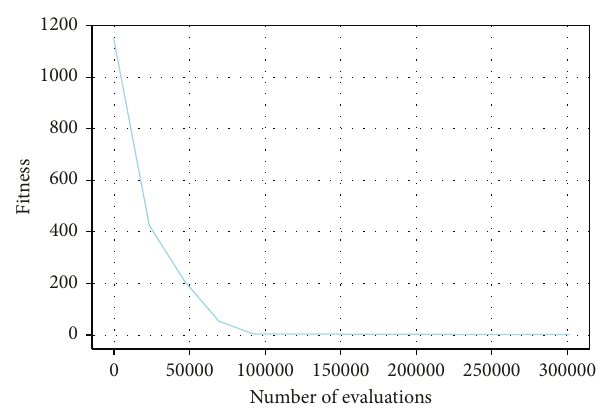
Figure 5: CEC14 Fun7 convergence plot.